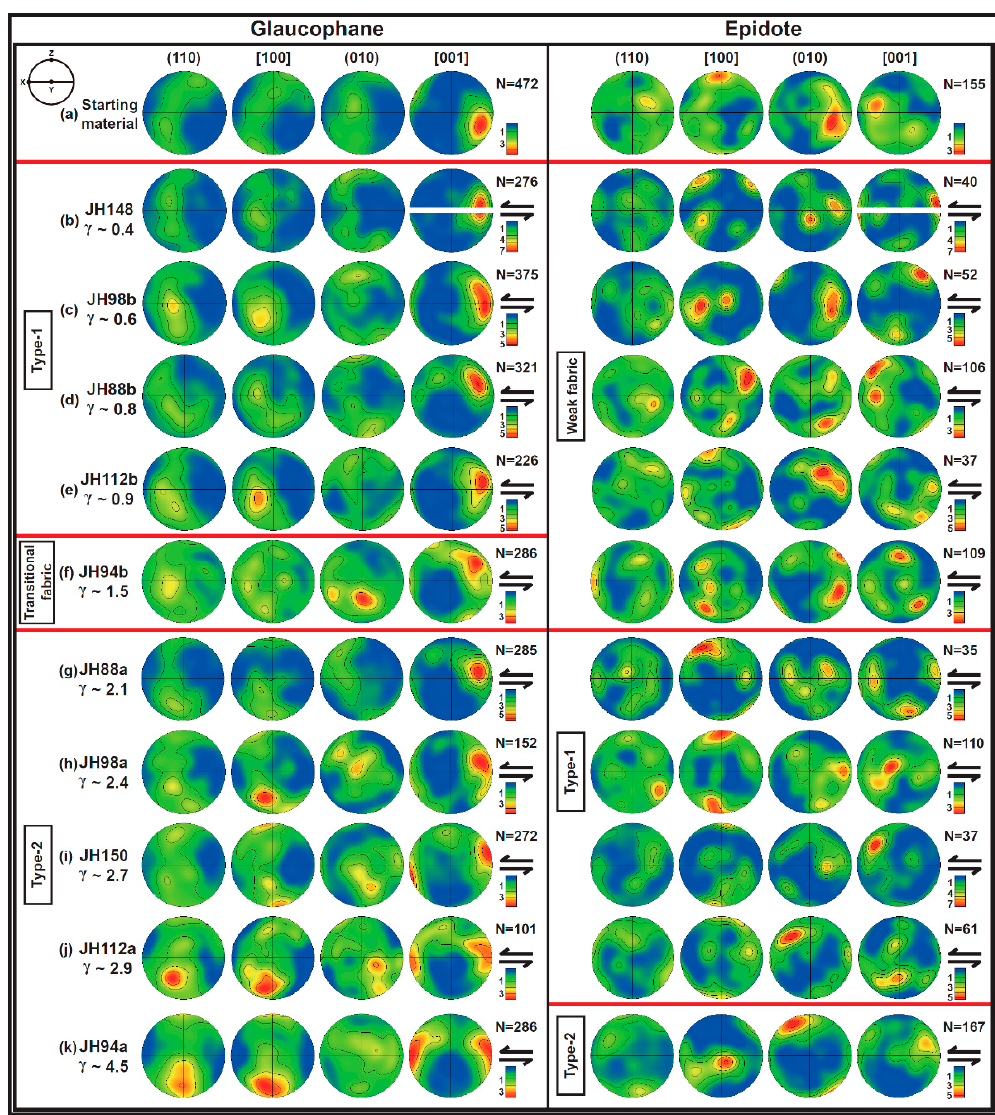
Figure 5. Pole figures of glaucophane and epidote in ( a ) starting material and ( b – k ) deformed samples showing LPO presented in the lower hemisphere using an equal-area projection. A half-scatter width of 30° was used. The X- and Z-directions correspond to the shear direction and the direction normal to the shear plane in the experiment, respectively. White line in pole figure: shear plane; black arrows: shear direction; and N: the number of grains.